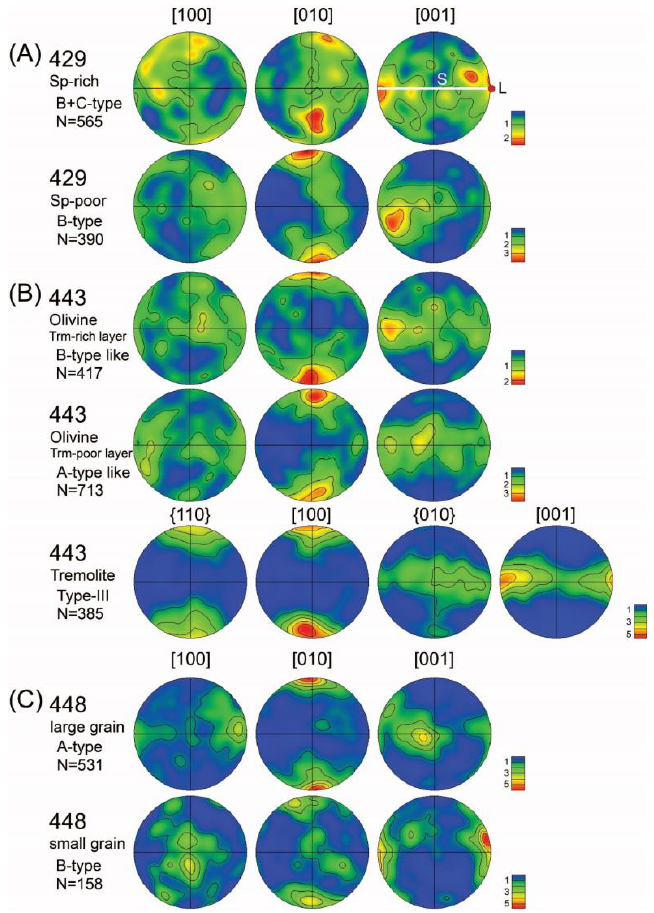
Figure 4. Pole figures of olivine presented in the lower hemisphere using an equal-area projection obtained from ( A ) the spinel-rich layer and a spinel-poor layer of sample 429, ( B ) the tremolite-poor layer and tremolite-rich layer of sample 443, and ( C ) large grains including the porphyroclasts and recrystallized small grains of sample 448. The pole figure of the tremolite from the tremolite-rich layer of sample 443 is also included in (B). The white line (S) represents foliation and the red dot (L) represents lineation. A half-scatter width of 20° was used. “N” represents the number of grains. The color-coding indicates the density of data points. The numbers in the legend correspond to multiples of uniform distribution.